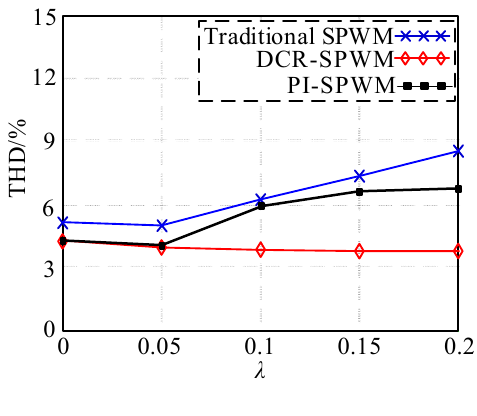
Figure 16. Measured THD.